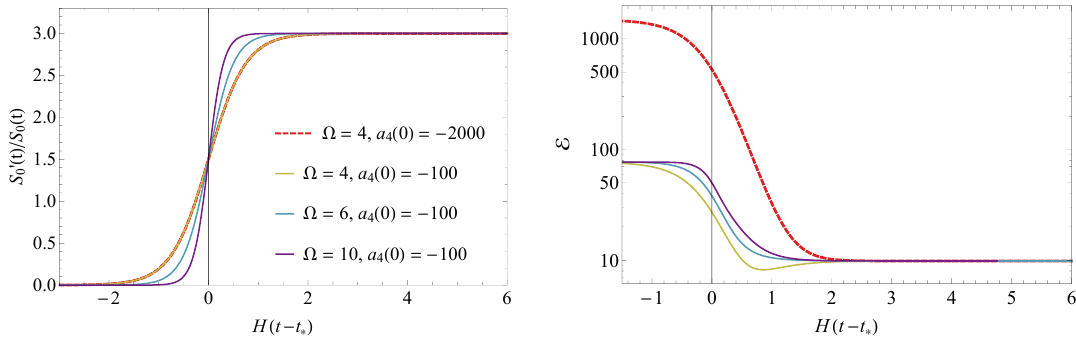
( t ) /S 0 ( t ) , all using our maximal value of H = 3 . (Right) 0